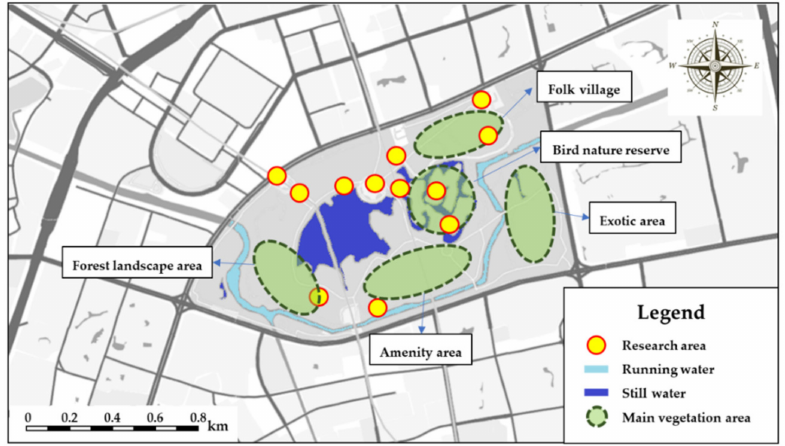
Figure 3. The greening rate in Shanghai Century Park is relatively high, with many still water areas and running water areas. The figure was created by the author.